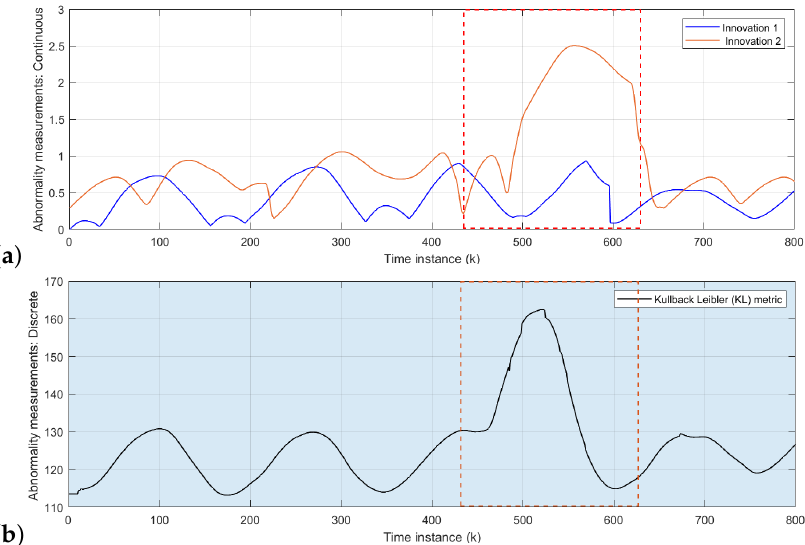
Figure 8. Abnormality measurements: Task 2 test data: ( a ) Continuous level anomaly: the blue and orange plots belong to the anomaly estimated for iCab1 and iCab2 , respectively. The highest peaks of the orange plot represent the situation where the iCab2 performed an emergency stop operation when it detected a pedestrian’s presence. ( b ) Discrete level abnormality: the peaks show the global anomaly detected by the